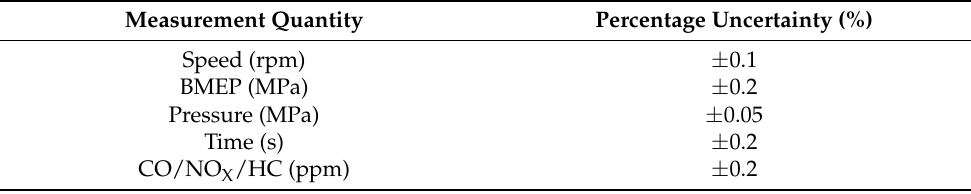
Table 4. Uncertainty analysis of the measured